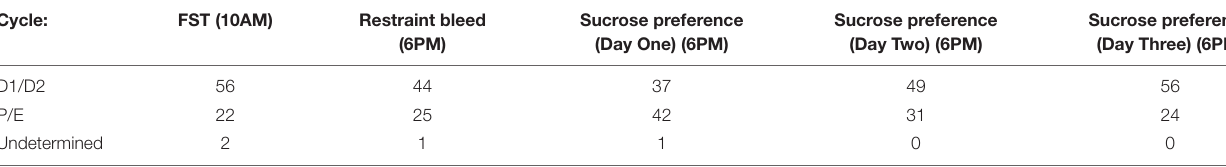
TABLE 1 | Number of animals in either D1/D2 or P/E on days of testing. Cycle: FST (10AM) Restraint bleed